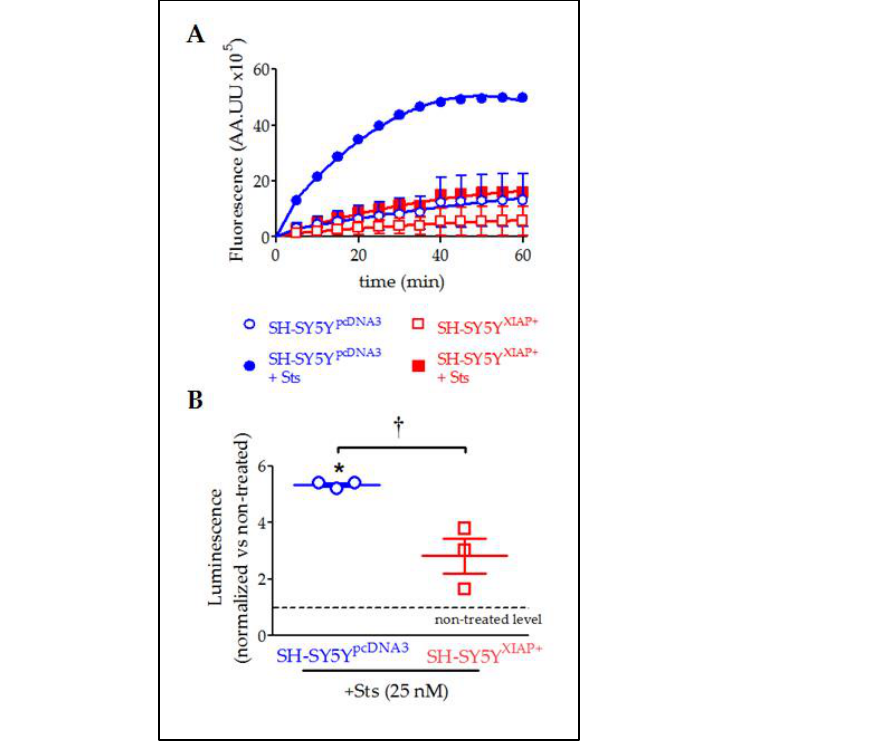
Figure 8. Reduction in Sts-induced activation of CASP3/7 by overexpression of XIAP in SH-SY5Y cells. ( A ) Kinetics of CASP3/7 activity in both SH-SY5Y pcDNA3 (blue symbols) and SH-SY5Y XIAP+ cells (red symbols), treated at time 0 with Sts (filled symbols) or vehicle (empty symbols). ( B ) The dot plot summarises the Sts effect in CASP3/7 activity for SH-SY5Y pcDNA3 (blue symbols) and SH-SY5Y XIAP+ cells (red symbols). Data were normalised by non-treated levels (dot line) after 30 min (dot plot represents means ± SEM; * = p -value < 0.05 in paired Student’s t -test for Sts-treated SH-SY5Y pcDNA3 vs. vehicle-treated cells; † = p -value < 0.05 in a two-way ANOVA of genetic background effect; n = 3 independent experiments)